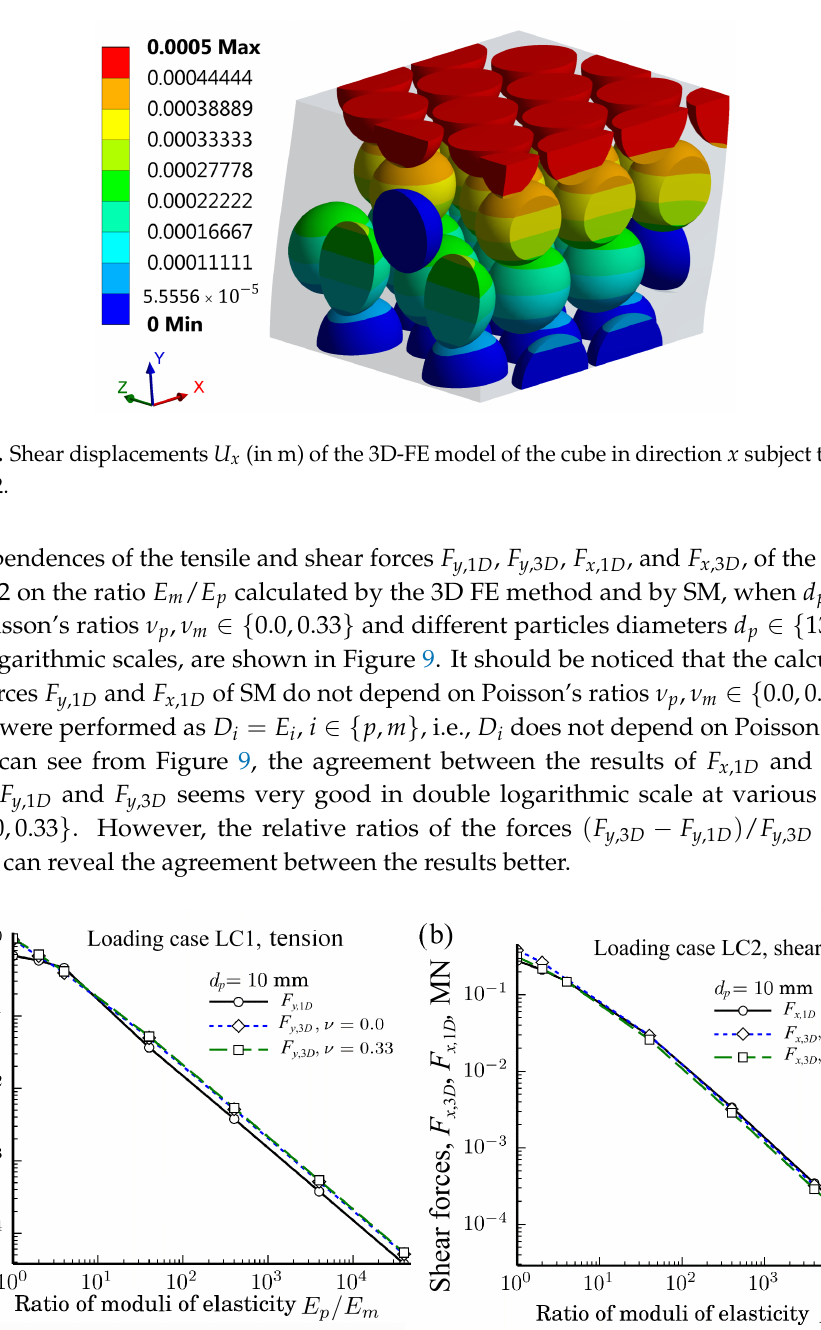
Figure 9. Dependences of the tensile forces F y ,3 D and F y ,1 D for ( a ); and the shear forces F x ,3 D and F x ,1 D for ( b ) of the loading cases LC1 and LC2 on the ratio E p / E m at different Poisson’s rations ν p ∈ { 0.0,0.33 } when particles’ diameters d p = 10